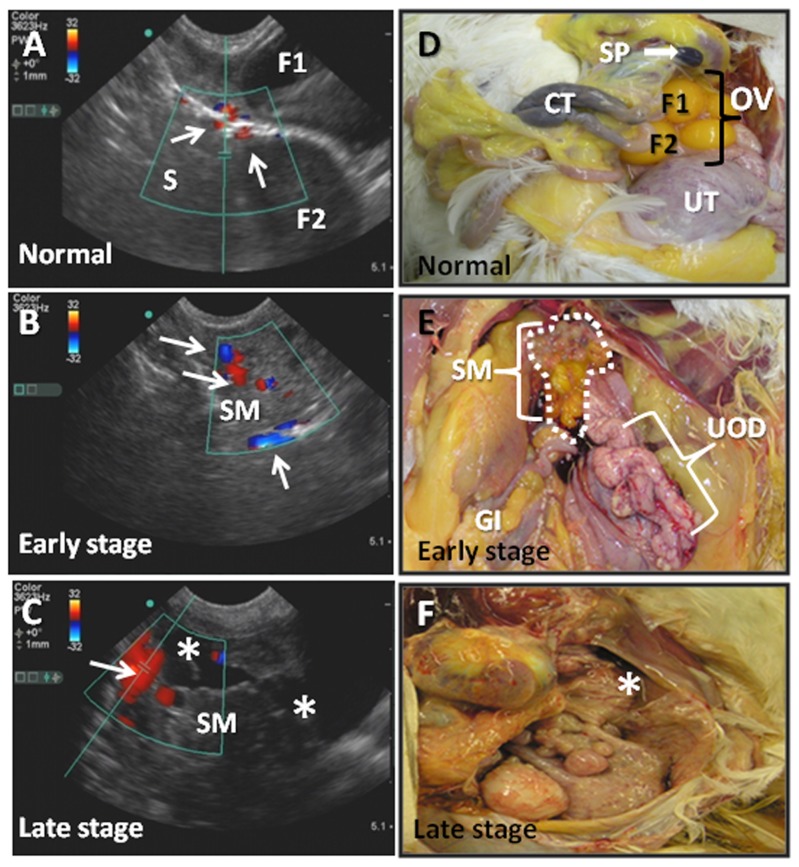
Selection of hens with normal ovaries or ovarian tumors using (A–C) color Doppler ultrasound and (D–F) gross morphology of the ovaries.A normal ovary (A and D) with maturing ovarian follicles (F1, F2) and stromal blood vessels (arrows) with normal gross morphology showing maturing (F1, F2) ovarian follicles. An example of an abnormal ovary (B and E) that contains more blood vessels (arrows) than in the normal ovary, no detectable large mature follicles and a small solid tissue mass (circle) in the ovary. An example of late stage ovarian cancer (C) characterized by a large solid mass with increased blood flow (arrows) and profuse ascites (*).The gross morphology (F) confirmed the presence of multiple solid masses and tumor metastasis to other organs. Abbreviations: CT = cecal tonsil; F1–F2 = large preovulatory follicles; GI = gastrointestinal tract; OV = ovary; S = ovarian stroma; SM = solid tissue mass in the ovary; SP = spleen; UOD = upper oviduct; UT = uterus.